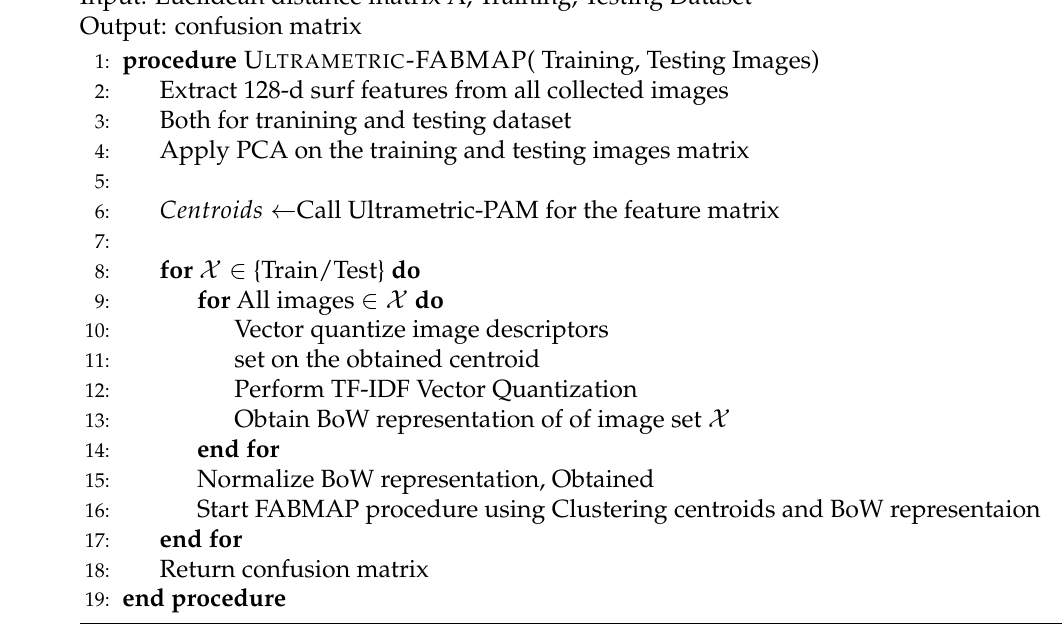
Algorithm 4 (Ultrametric-FABMAP). Runs FABMAP with the transformed distance